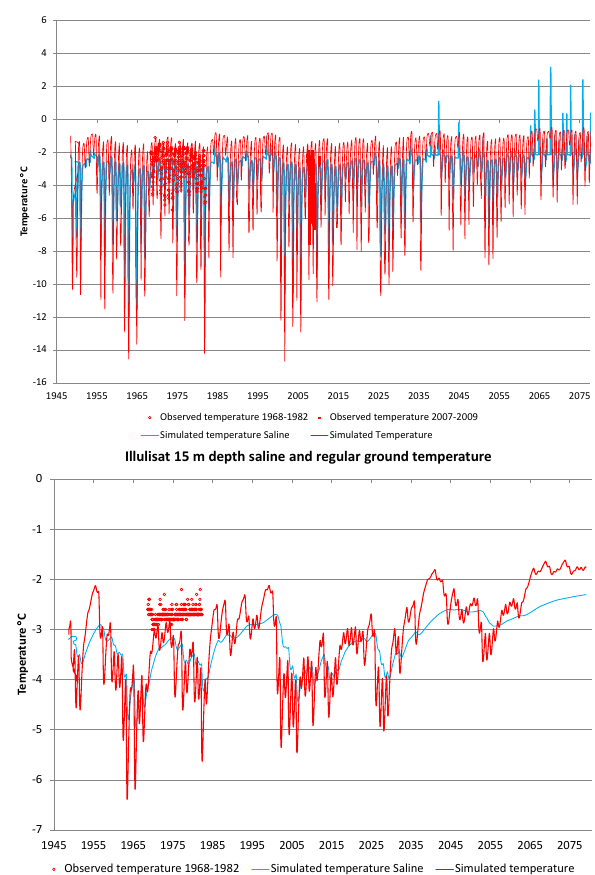
Fig. 8. Temperature time series for an area near Ilulissat for 2.5m depth (A) and 15m depth (B) , comparing saline and regular temper- ature simulation in a sediment basin. The older data from Olesen (2003) and the recent data collected as part of the present study are from different locations in